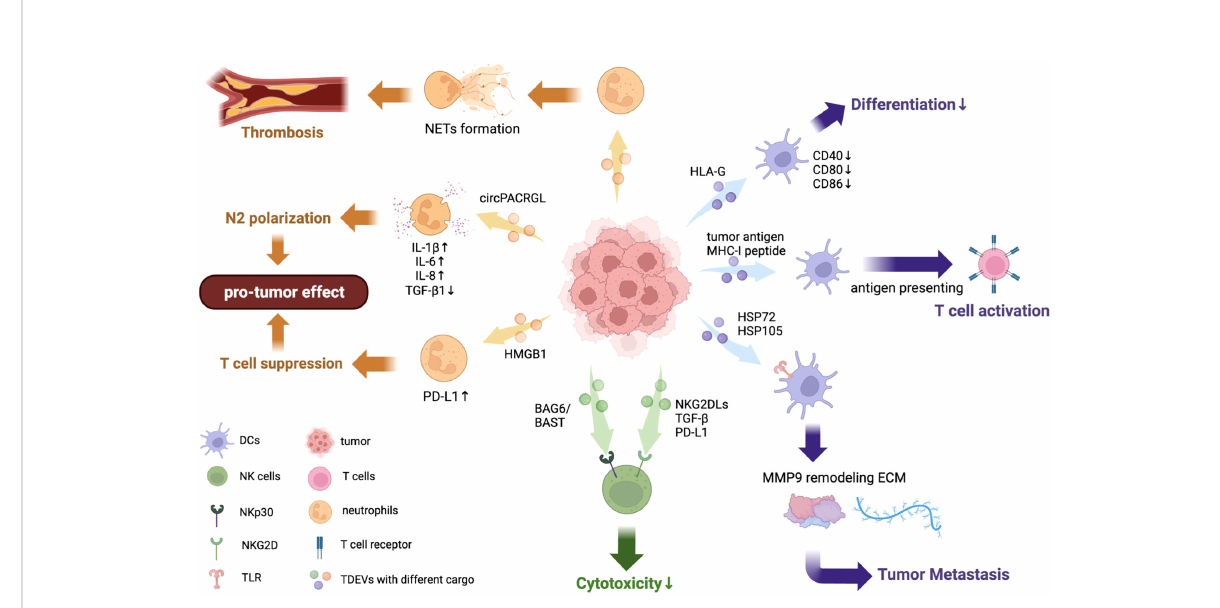
FIGURE 2 Effects of TDEVs in regulating DCs, neutrophils, and NK cell functions. TDEVs can interact with innate immune cells including DCs, neutrophils, and NK cells, exerting a dual effect in regulating their functions. TDEVs to DCs: EVs containing tumor antigen from HCC can transfer it to DCs and further activate T cell immunity, indicating its anti-tumor effect. TDEVs can impair DCs differentiation and maturation to suppress immune responses in some cancers, HLA-G is identi fi ed as a key factor in this negative regulation. Some TDEVs contain HSP72 and HSP105 bind with TLR on DCs to increase MMP9 expression, reorganizing ECM and contributing to tumor invasion. TDEVs to neutrophils: circRNA PACRGL in CRC-derived EVs are engulfed by neutrophils and down-regulate TGF- b 1 expression, further inducing polarization to the N2 phenotype.